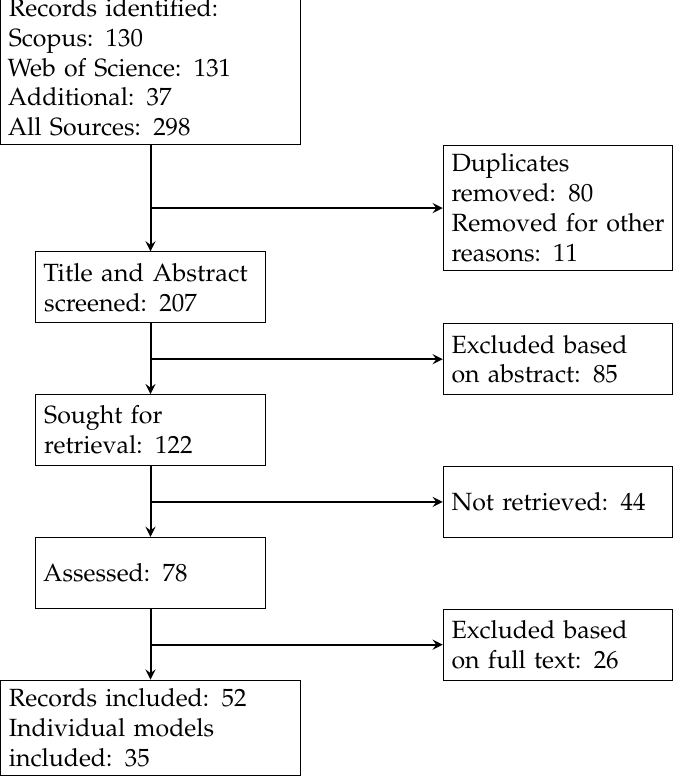
Figure 2. Records identified and included or excluded in the